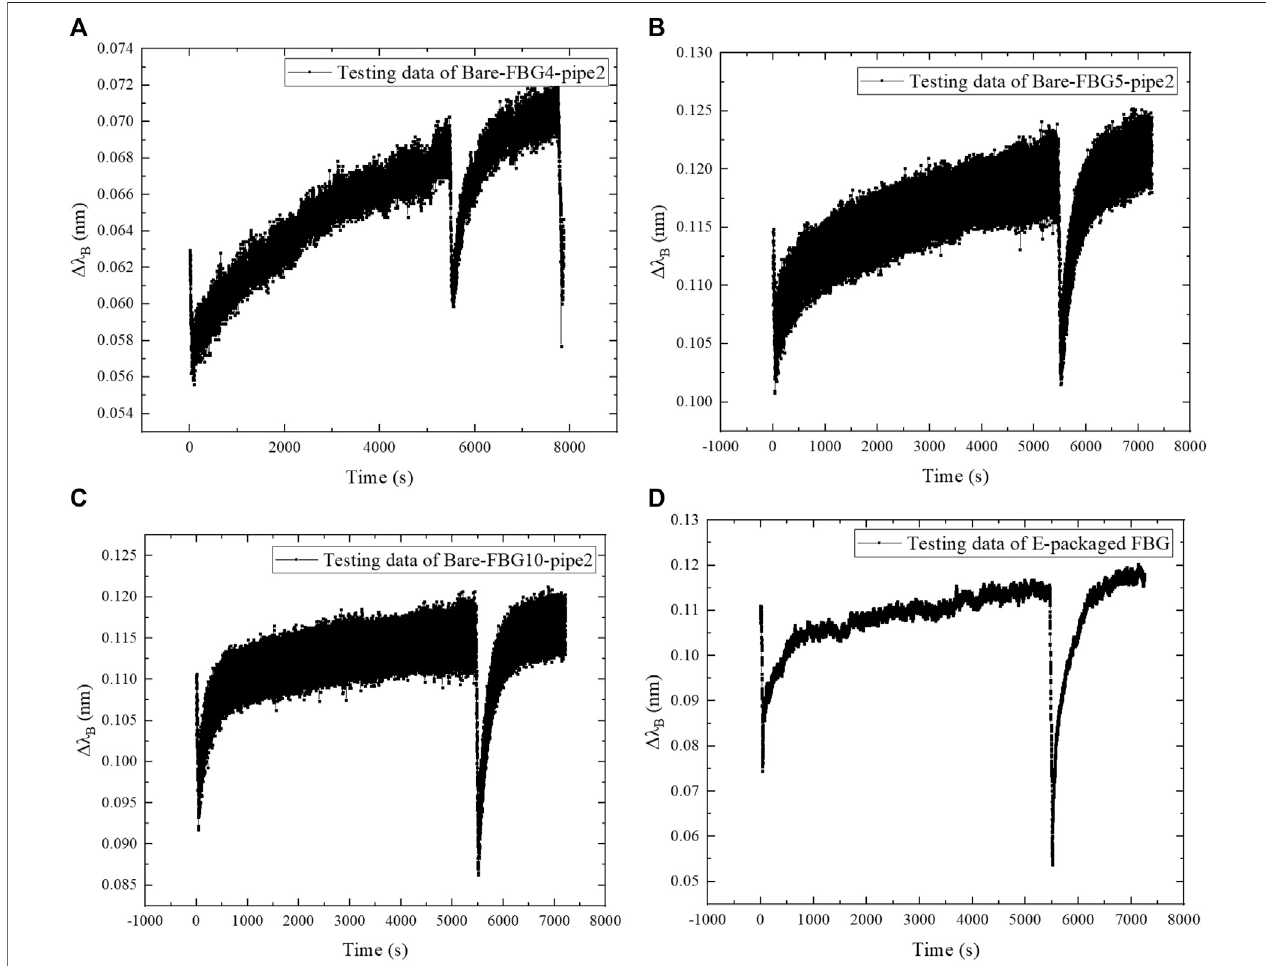
FIGURE 7 | Relationship of central wavelength increment with loading time at 20 Hz: (A) Bare-FBG4-pipe2; (B) Bare-FBG5-pipe2; (C) Bare-FBG10-pipe2; (D) E-packaged FBG.